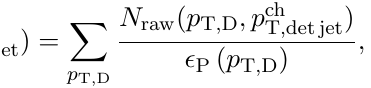
Figure 2 . Product of acceptance and e(cid:14)ciency of D 0 -meson jet reconstruction as a function of p T ; D . Left: acceptance (cid:2) e(cid:14)ciency for prompt D 0 -meson jets with 5 < p ch 15 < p ch < 30 GeV =c (open circles). Right: prompt (circles) and non-prompt (squares) D 0 T ; jet